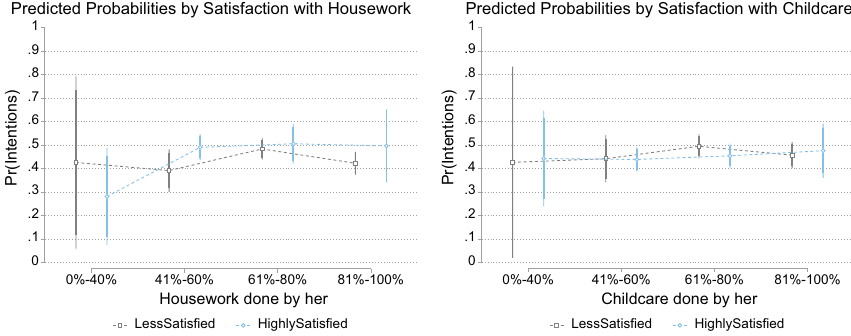
Fig. 4 Predicted probabilities of one-child mothers’ fertility intentions. Interaction between housework/ childcare distribution and mothers’ satisfaction. Error bars at 90% (thin) and 95% (thick). Models control for housework/childcare duties done by other individuals, woman’s age, child’s age, migrant background, women’s attachment to the labour force, men’s labour force status, differences in partners’